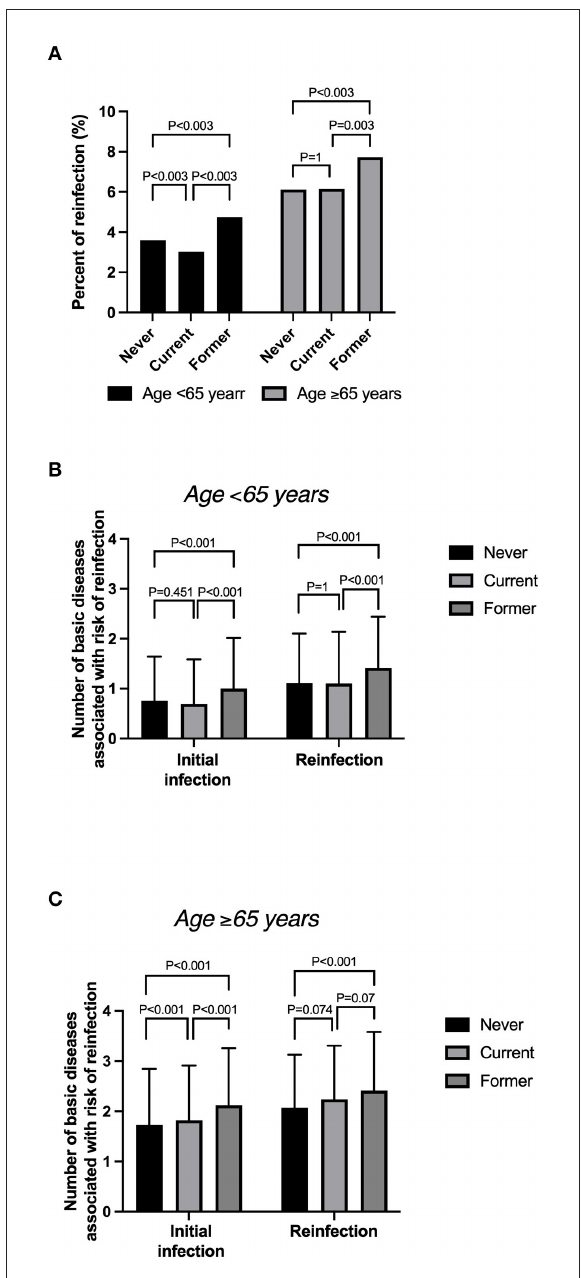
FIGURE3 (A) Reinfection rate by smoking status among patients aged > 65 and < 65 years. (B) Mean number of basic diseases by smoking status among those aged < 65 years. (C) Mean number of basic diseases by smoking status among those aged ≥ 65